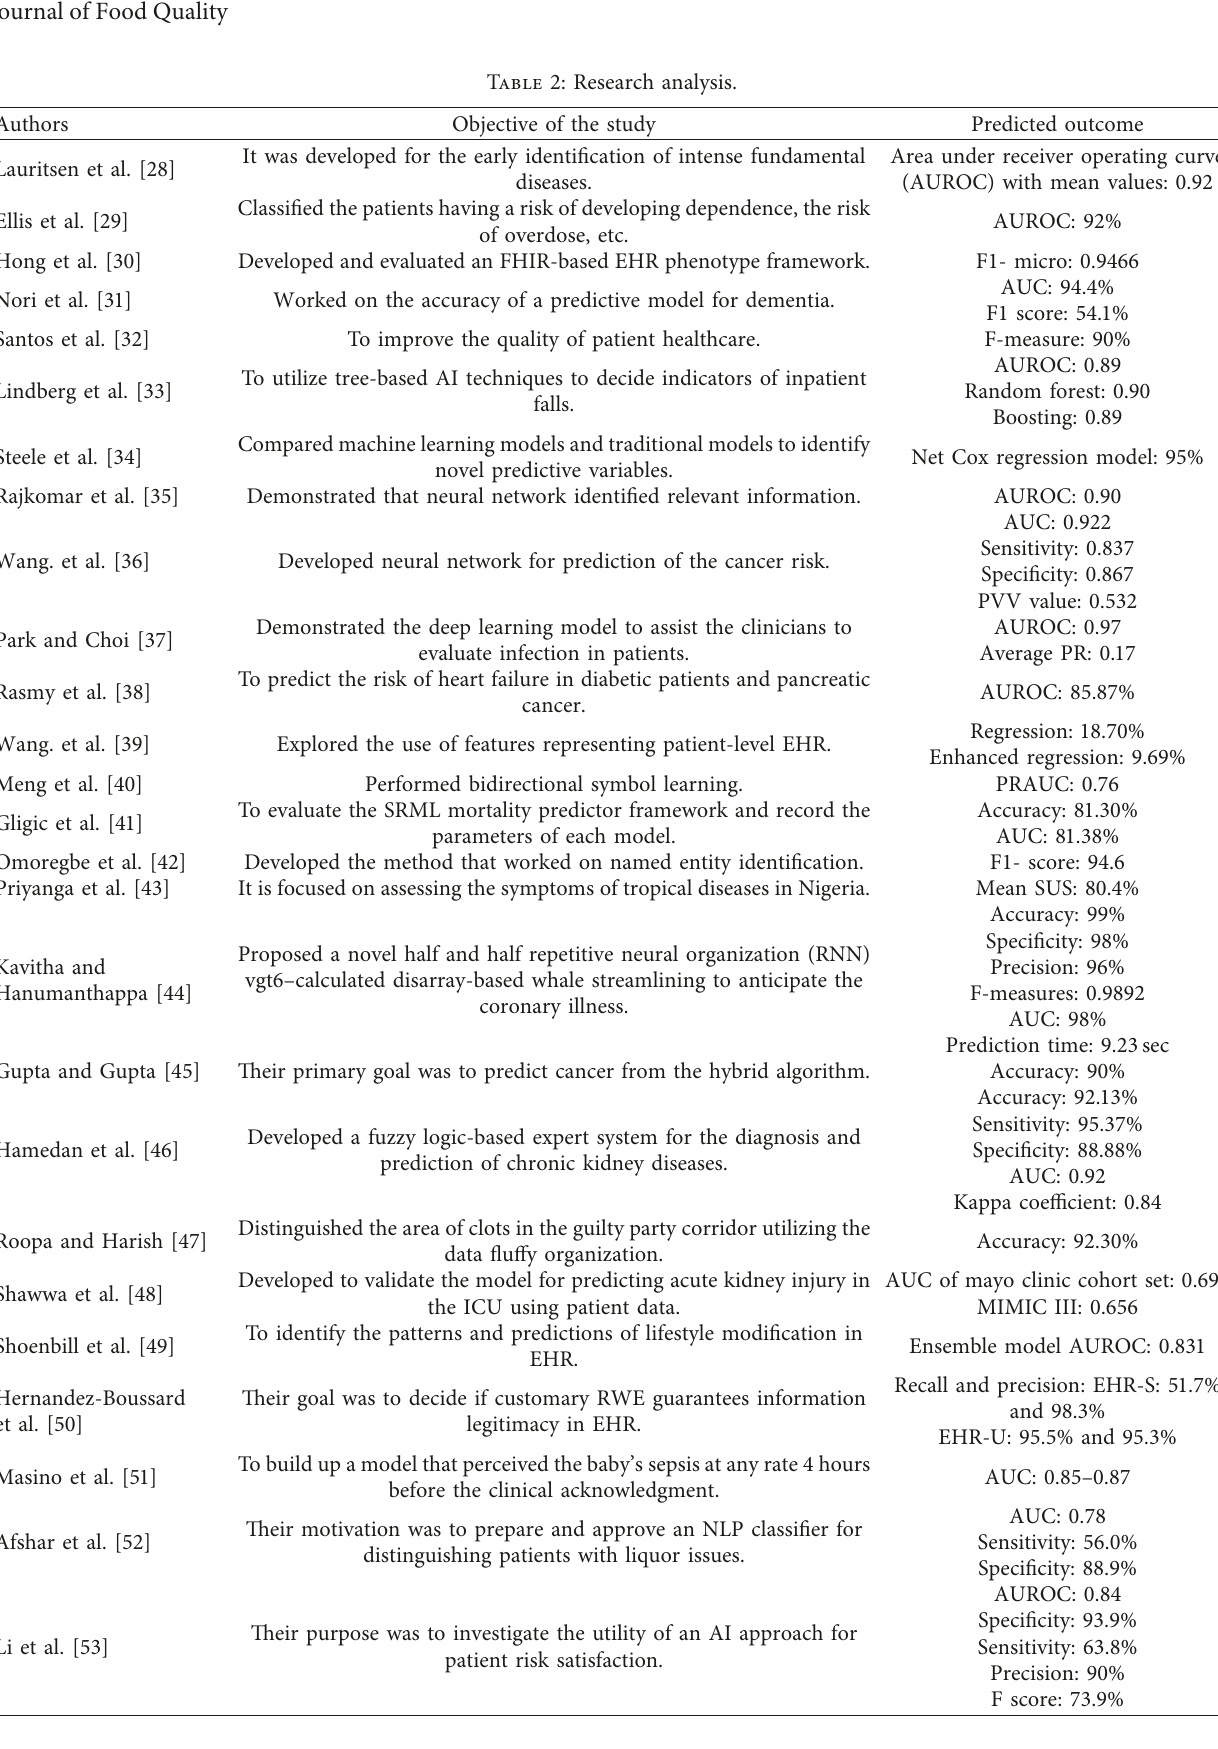
Table 2: Research